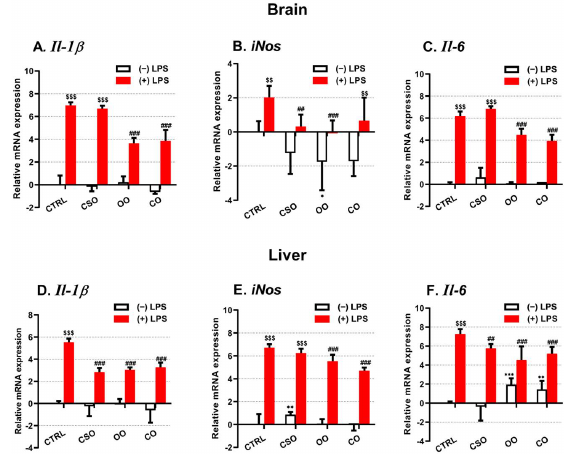
Figure 1. Effect of cactus seed oil, olive oil, or colza oil treatment on gene expression of the proin- flammatory markers Il-1β ( A , D ), iNos ( B , E ), and Il-6 ( C , F ), in the brain and liver, respectively. Male C57BL/6 mice received for 28 days a standard diet (control (CTRL)), a diet enriched with 6% ( w / w ) CSO, OO, or CO, and intravenous injection of LPS (100 µg) four hours antemortem. First, total RNA was isolated from mice brains or livers, and then the expression level of genes of interest was quan- tified by real-time RT-qPCR. All values are means ± SD (n = 4-6), statistical significance of higher mean signal (*** p ≤ 0.001. ** p ≤ 0.01. * p ≤ 0.05) compared to control, (### p ≤ 0.01. ## p ≤ 0.01) compared to LPS, and ($$$ p ≤ 0.001. $$ p ≤ 0.01) compared to the different treatments with or with- out LPS administration. Statistics were executed using two-way ANOVA followed by Tukey test for multiple comparisons.